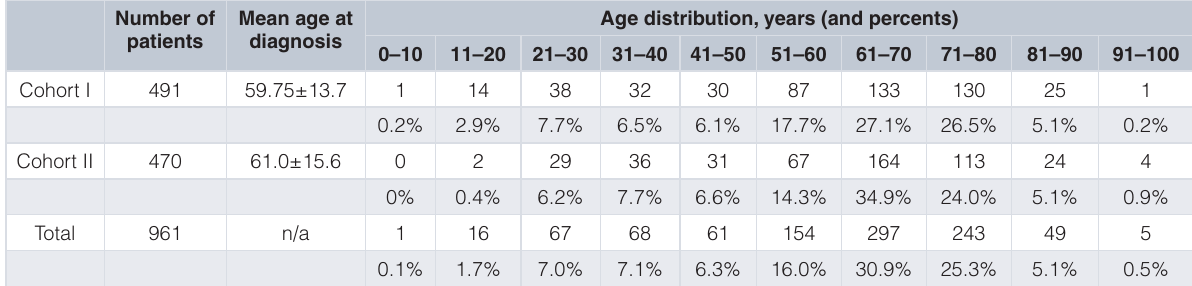
Table 1. Patient demographics in two cohorts (overall